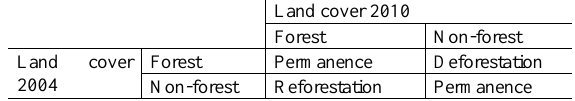
Table 2. Forest change for Ayuquila Basin (2004 – 2010)